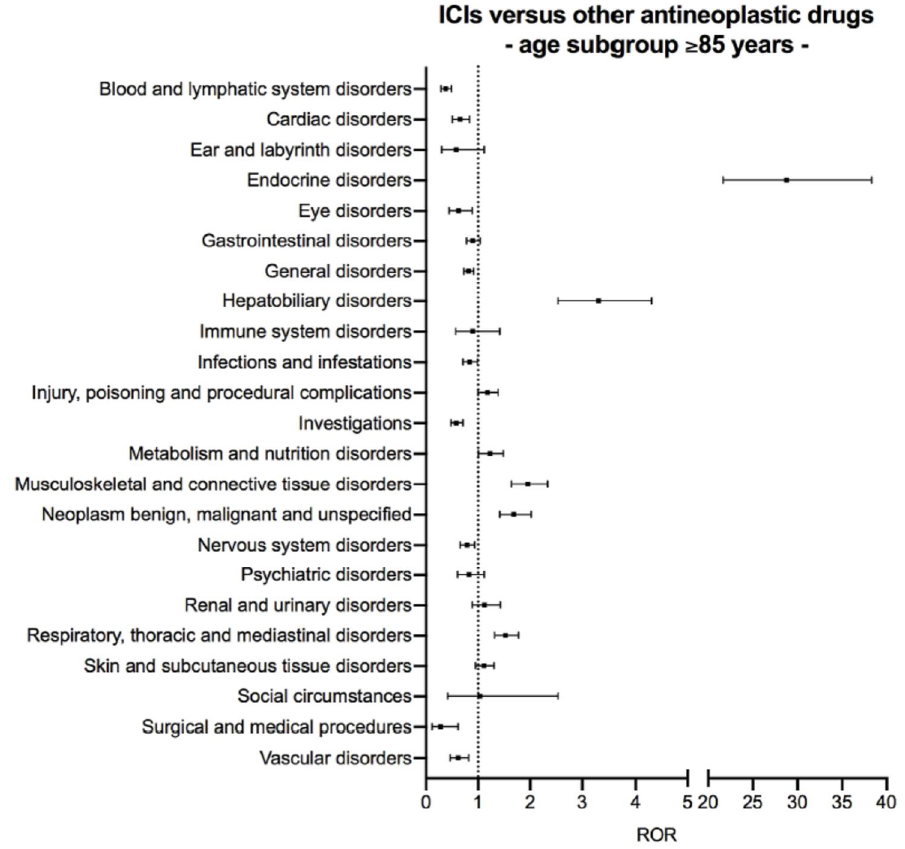
Figure 4. Age subgroup disproportionality analysis of safety reports associated with either immune checkpoint inhibitors or other antineoplastic drugs in older patients (aged ≥ 65 years). Suspected adverse drug reactions were clustered according to the Medical Dictionary for Regulatory Activities (MedDRA) System Organ Classes, version 23.0. Vertical bars on the ROR estimates indicate the 95% confidence intervals. Abbreviations: ICI, immune checkpoint inhibitor; ROR, reporting odds